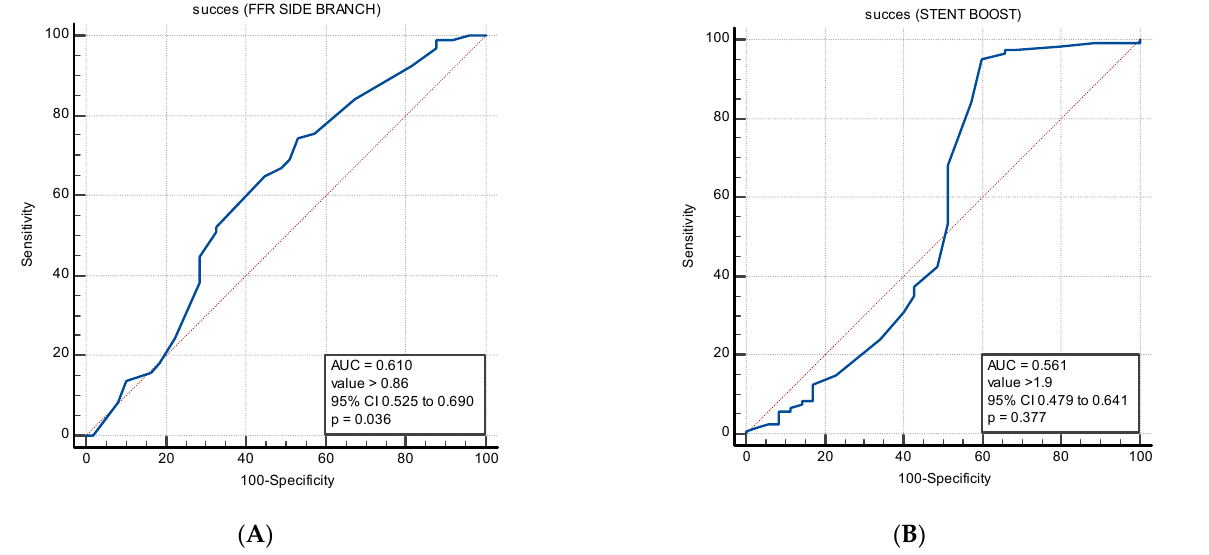
Figure 2. ROC curves showing the prognostic sensitivity and specificity of ( A ) FFR values to predict a value of SESBL > 2. The AUC of FFR (0.61, 95% CI 0.525–0.690, p = 0.036) with the optimal cut-off value of >0.86, which provided Se = 74.5% and SP = 47% for the prediction of SESBL values > 2. ( B ) SESBL values to predict a value of FFR > 0.8. The AUC of SESBL (0.56,95% CI 0.479–0.641, p = 0.38) with the optimal cut-off value of >1.9, which provided Se = 95% and SP = 40% for the prediction of FFR values > 0.8.